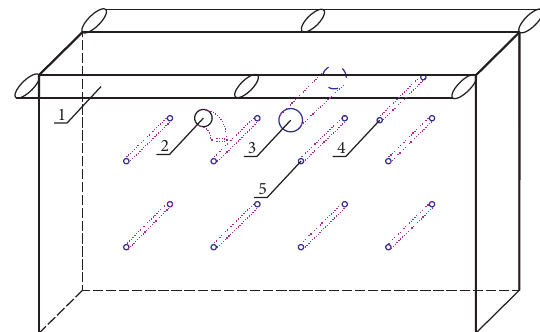
Figure 1: Schematic diagram of mold